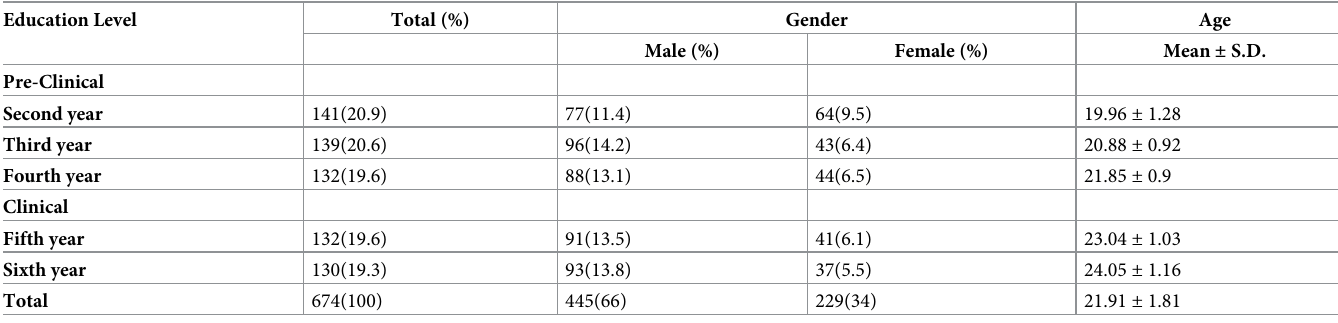
Table 1. Basic characteristics of participants (n =